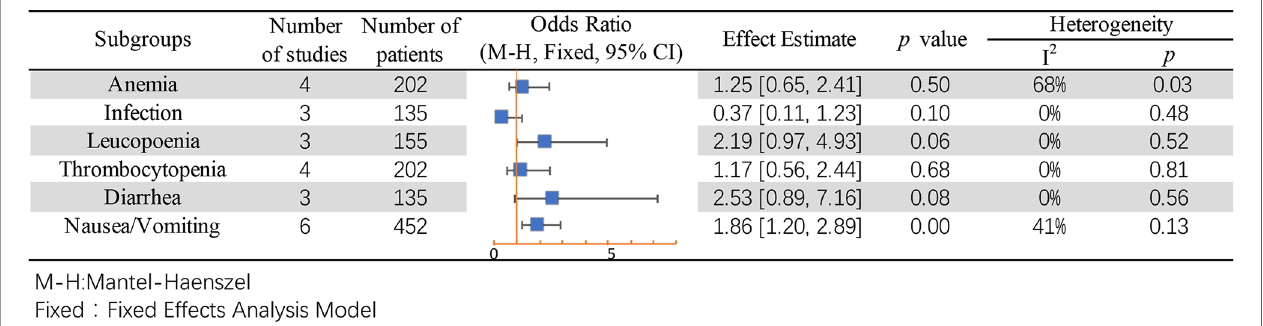
FIGURE 9 | Adverse events of mannitol use in cisplatin-induced nephrotoxicity.